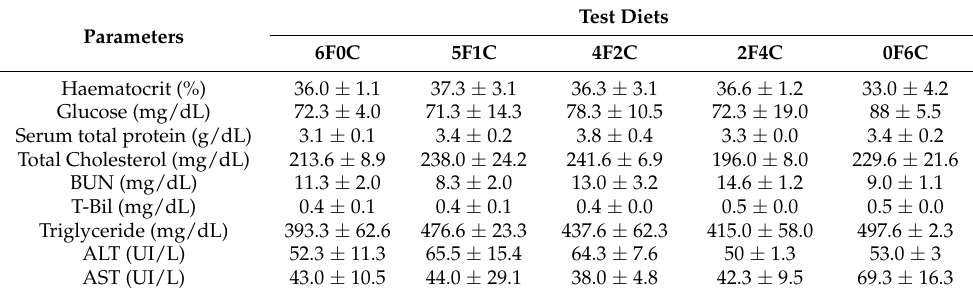
Table 8. Blood health of red seabream ( Pagrus major ) fed the experimental diets for 56-days.